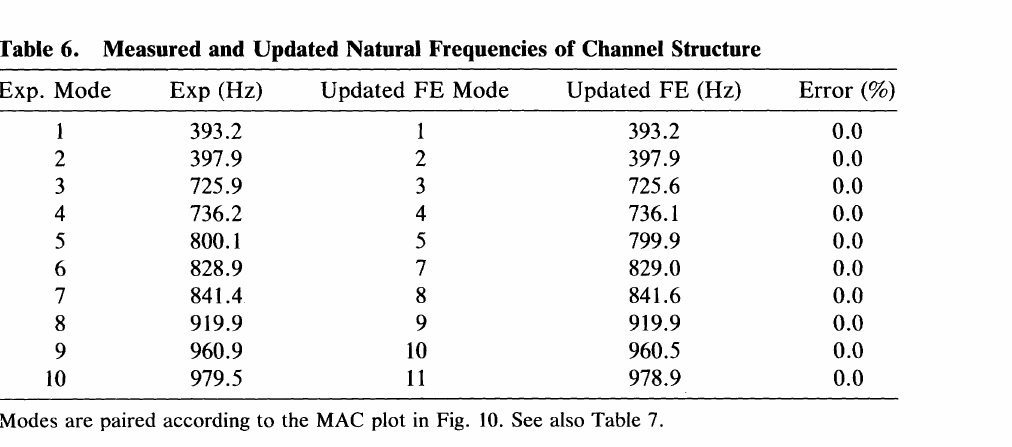
Table 6. Measured and Updated Natural Frequencies of Channel Structure